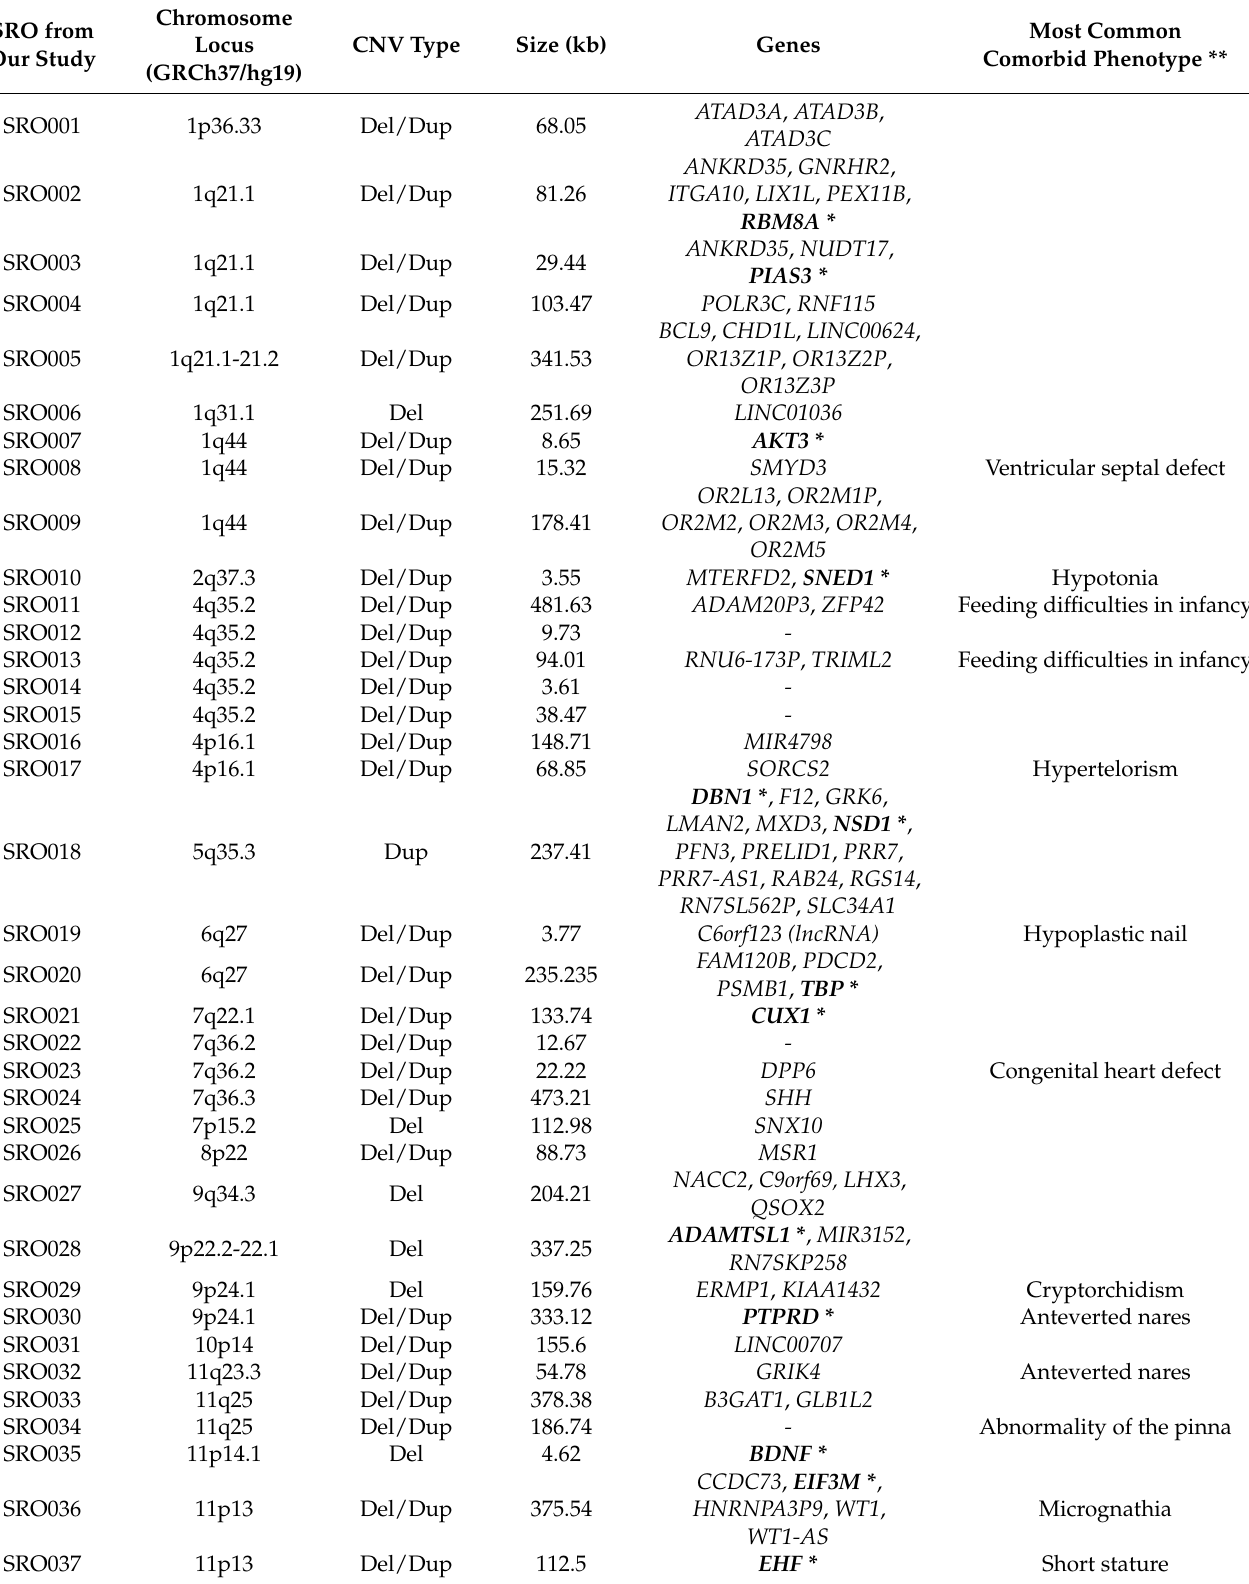
Table 2. Candidate genes in